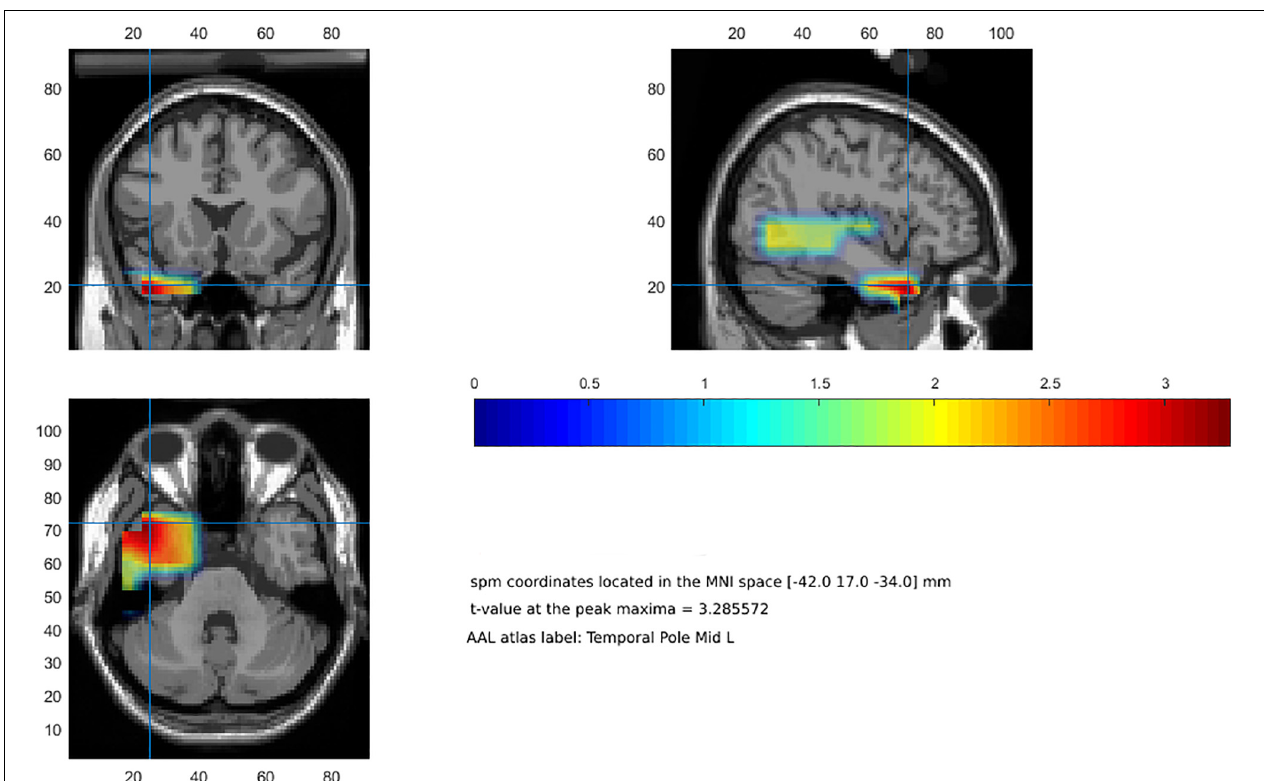
FIGURE 2 | Beamforming reconstruction of the neural sources of gamma activity observed at the scalp level (fear-related words > anger-related words). Color bar represents t